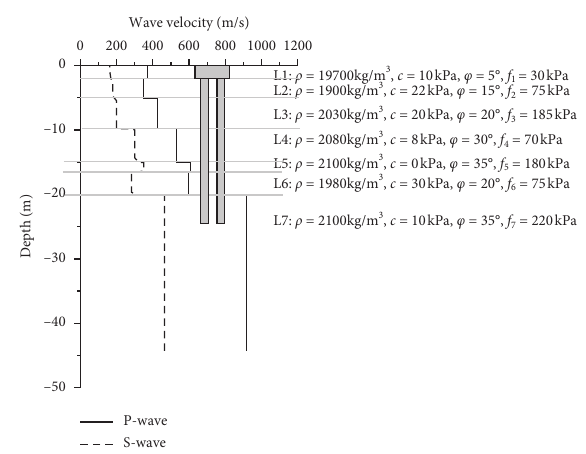
Figure 4: Soil layers and their parameters around the test bridge foundation.